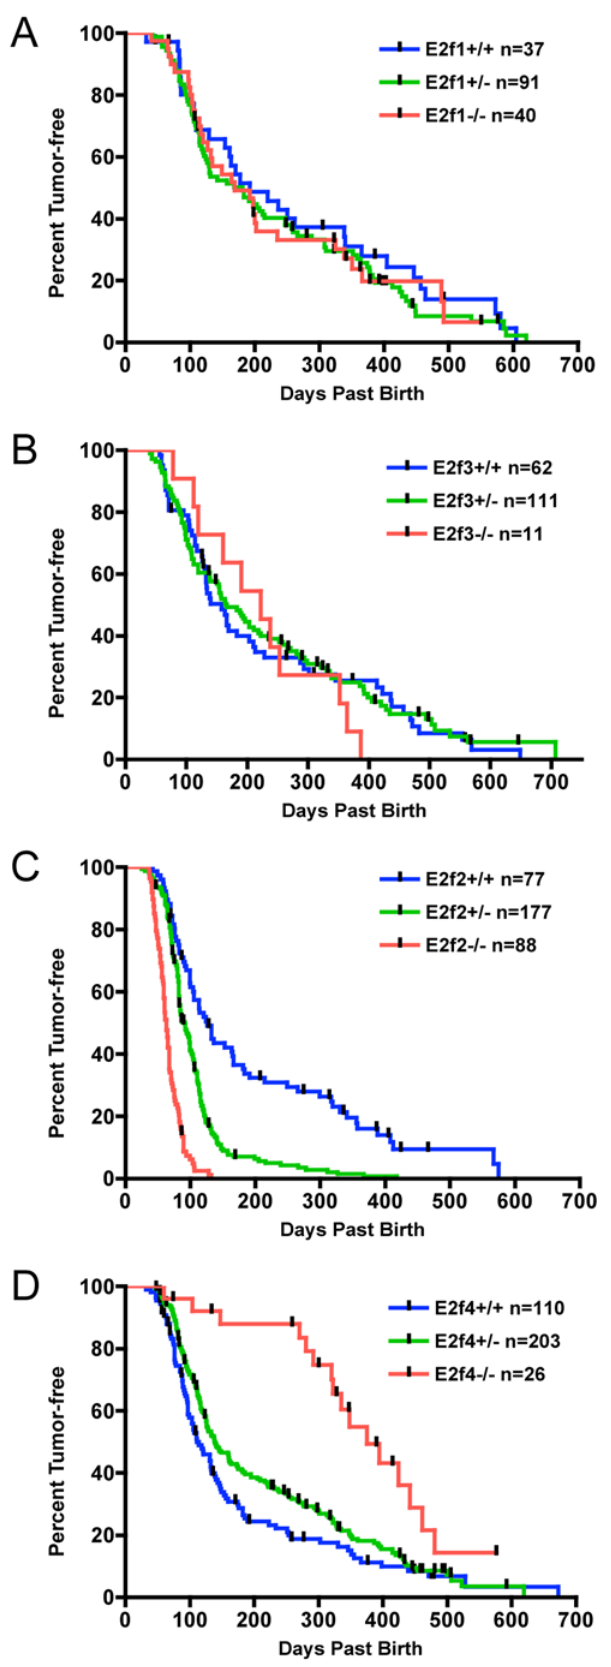
Figure 1. Myc-induced lymphomagenesis is influenced by E2F status. (A) Kaplan-Meier survival analysis showing the percentage of tumor-free E m - myc mice with the indicated E2F1 genotypes ( E2f1 + / + , E2f1 + / 2 , and E2f1 2 / 2 sibling mice in the E2F1 cohort) plotted against the onset of disease. Onset of disease did not vary with E2F1 status. (B) Same as (A) but for E2f3 + / + , E2f3 + / 2 , and E2f3 2 / 2 sibling mice in the E2F3 cohort. Onset of disease did not vary with E2F3 status. (C) Same as (A) but for E2f2 + / + , E2f2 + / 2 , and E2f2 2 / 2 sibling mice in the E2F2 cohort. Disease onset was faster in E2f2 2 / 2 E m - myc mice (median age 63 days) than in E2f2 + / + E m - myc mice (median age 126 days), and the onset curves were significantly different (P , 0.0001). E2f2 + / 2 E m - myc mice exhibited an intermediate onset of disease (median age 92 days), and the onset curve was significantly different from that of the E2f2 + / + E m - myc mice (P , 0.0001) and the E2f2 2 / 2 E m - myc mice (P , 0.0001). (D) Same as (A) but for E2f4 + / + , E2f4 + / 2 , and E2f4 2 / 2 sibling mice in the E2F4 cohort. Disease onset was slower in E2f4 2 / 2 E m - myc mice (median age 375 days) than in E2f4 + / + E m - myc mice (median age 110 days), and the onset curves were significantly different (P , 0.0001). Relative to the E2f4 + / + E m - myc mice, E2f4 + / 2 E m - myc mice may have a slightly delayed disease onset (P ,